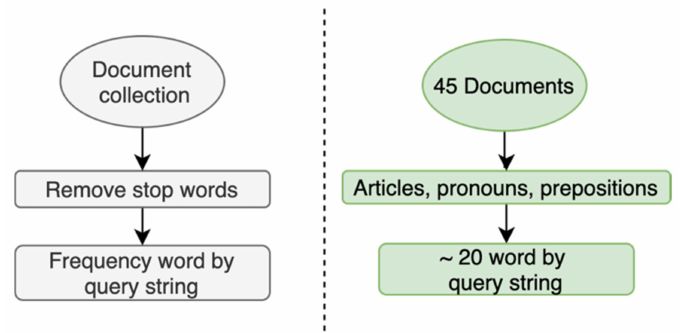
Figure 4. The process of text analysis. 1. Flowchart on the left: shows the general process steps: “Remove stop words” and “Frequency Words” to identify a list of concepts by the query string. 2. Flowchart on the right: shows the result for the HMP-Coffee model.